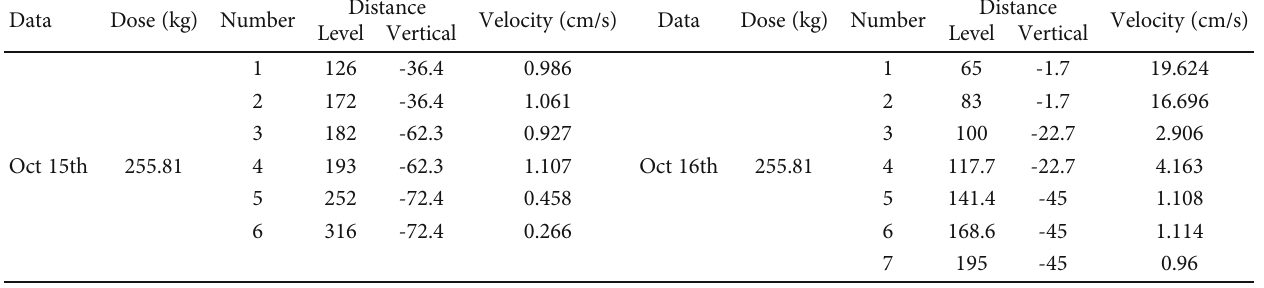
Table 1: Measurement point blasting vibration monitoring data.